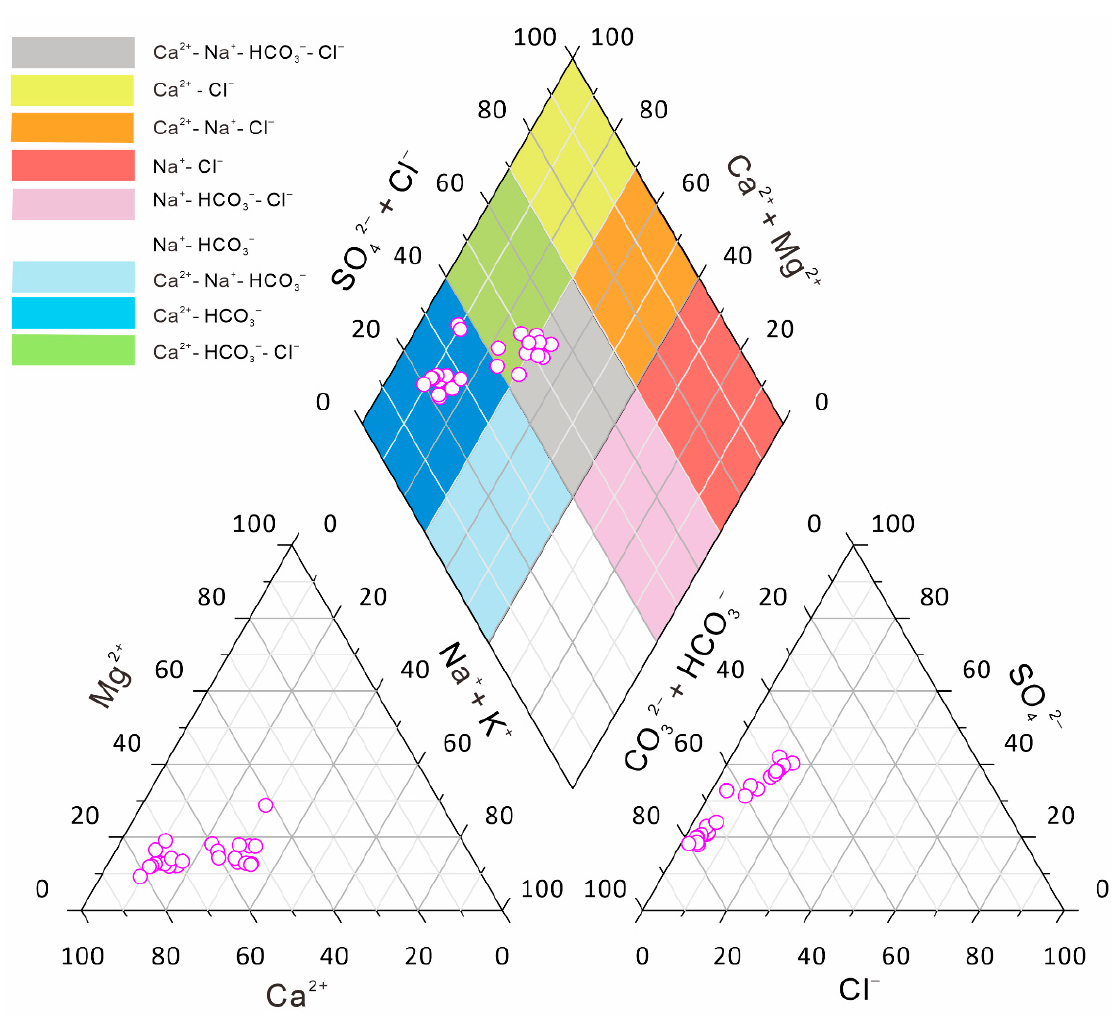
Figure 4. Piper diagram with hydrochemical types for water samples from the region of the Tianshan Mts.